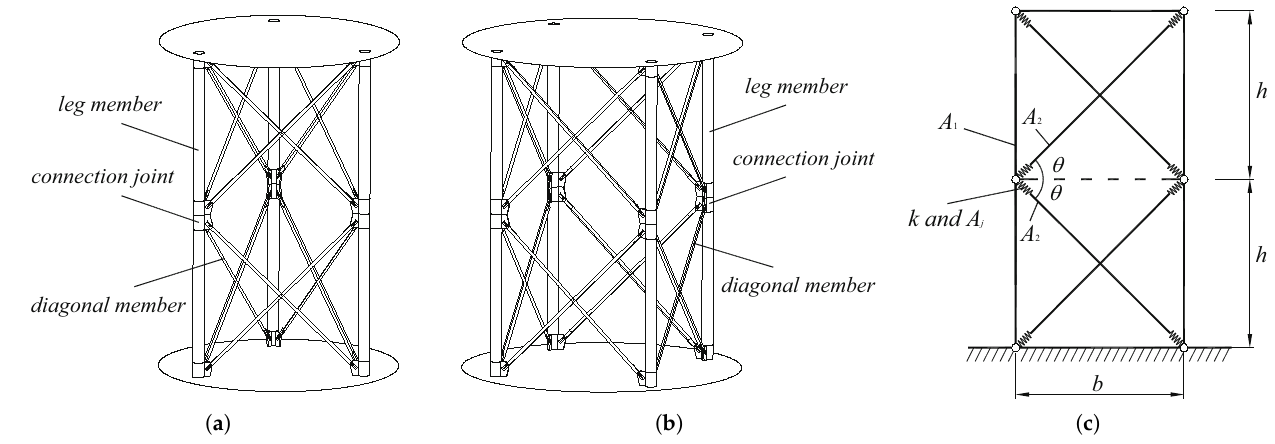
Figure 3. ( a ) The triangular lattice tower. ( b ) The quadrilateral lattice tower. ( c ) The mathematical model of the tower.